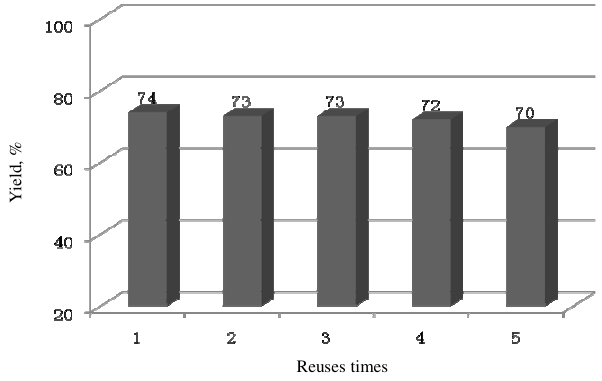
Figure 1. Reusability of [TMPSA] [HSO